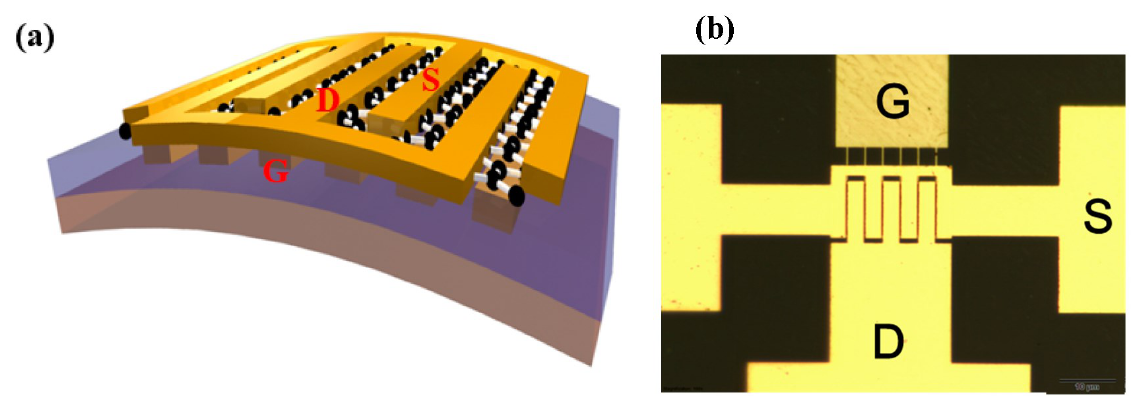
Figure 1. ( a ) 3D view of multi-fingered GFET on flexible polyimide film; ( b ) Enlarged optical image of a representative GFET transistor.